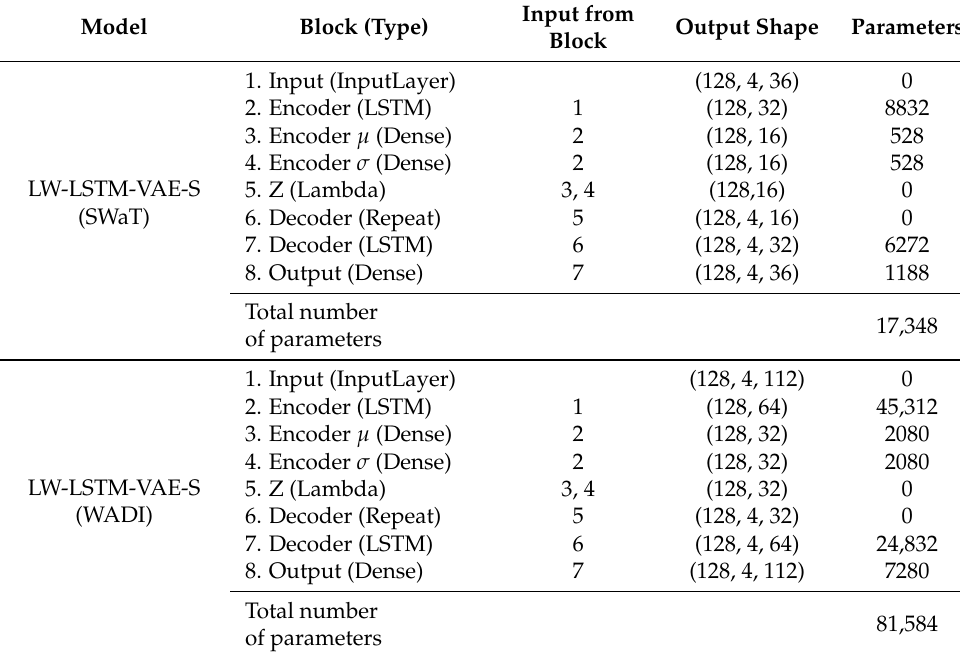
Table 5. The neural network architecture of our LW-LSTM-VAE-S models. The particular architecture blocks, the type of the blocks, the output shapes, and the number of required parameters are listed for the respective